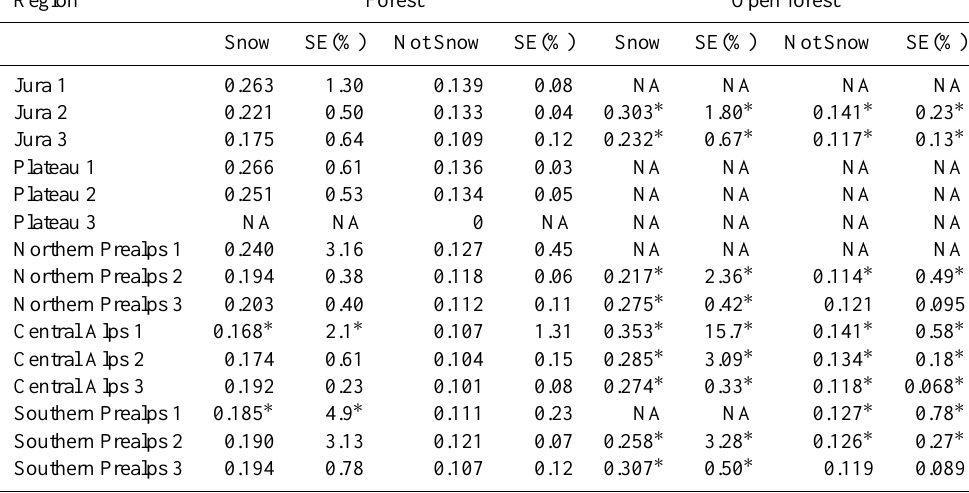
Table A1. Albedo of forest (snow, no snow) and open forest (snow, no snow) and corresponding standard errors (SE) of each biogeographical region. Values marked with ∗ were derived using majority pixels and/or magnitude inversion (see chapter albedo RF), all other values have been derived using 92% pixel cover and full inversion. Numbers 1–3 behind the biogeographical regions indicate the elevation (1 is below 600m, 2 is 600–1200m, 3 is above 1200m).